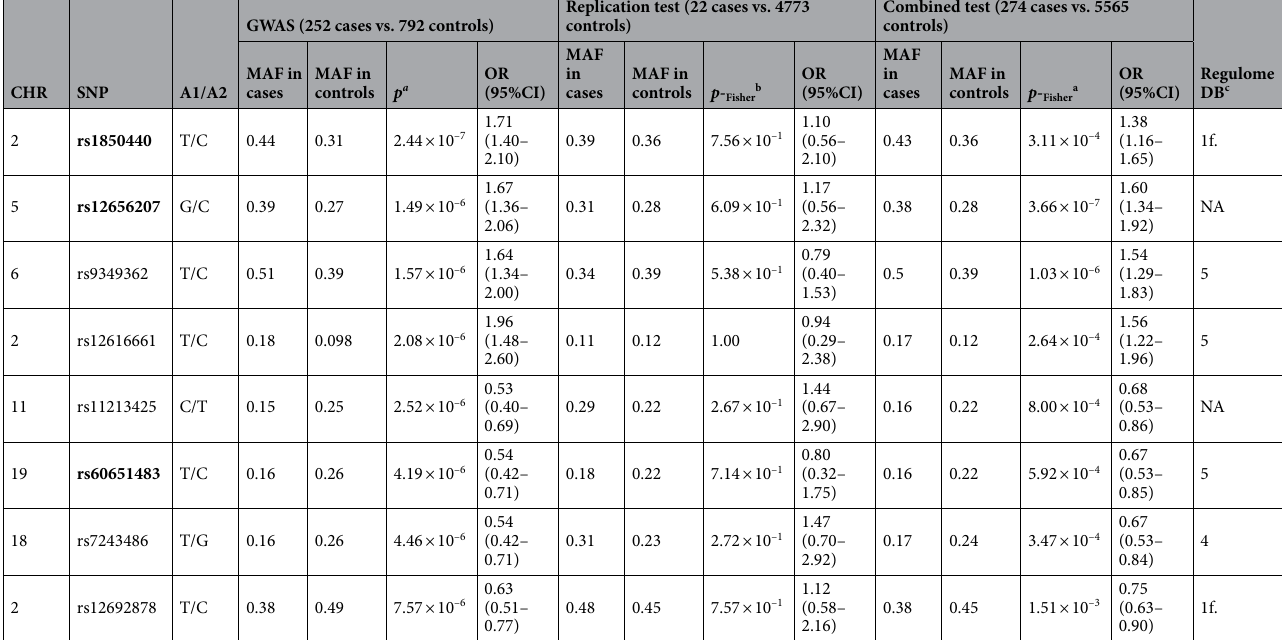
Table 2. Candidate SNPs associated with AESD. The SNPs with replicable odds ratios in the replication study were shown in bold. CHR: chromosome; A1: minor allele; A2: major allele; MAF: minor allele frequency; p - Fisher : p -value calculated using Fisher’s exact test; OR: odds ratio; 95% CI: 95% confidence interval; NA: not applicable. a Genome-wide significance p -value = 5.0 × 10 –8 , suggestive significance p -value = 1.0 × 10 –5 . b Significance levels were adjusted by the number of comparisons to correct for multiple testing. The significance level was set at p < 6.2 × 10 –3 (adjusted α = 0.05/8). c Functional prediction scores of each SNP